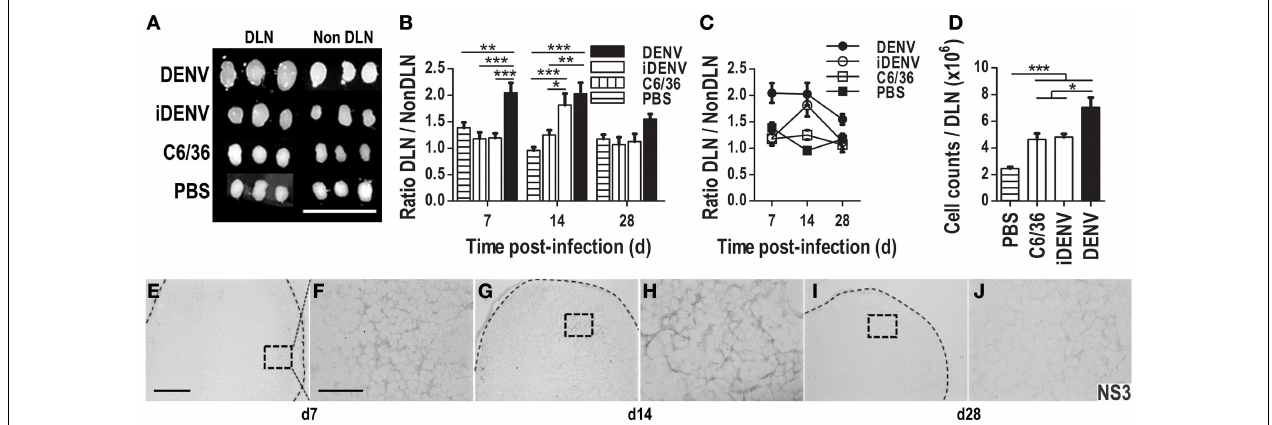
FIGURE 1 | Cutaneous inoculation of DENV infects immune- competent mice inducing an immune response . The size of draining lymph nodes (DLN) and non-DLN (contralateral inguinal LN) was compared among groups of immune-competent BALB/c mice inoculated with either intact DENV, UV-inactivated-DENV (iDENV), supernatant from uninfected C6/36 mosquito cell line (C6/36), or endotoxin-free PBS. (A) DENV induces the biggest DLNs post-inoculation (14days post-inoculation). (B,C) The ratio between the sizes of these LN (DLN/Non -DLN) at days 7, 14, and 28 post-inoculation. (D) The cellularity obtained per DLN at day 14 post-inoculation was higher in DENV inoculated mice than in mice inoculated with the other conditions. Data shown are pooled from three independent